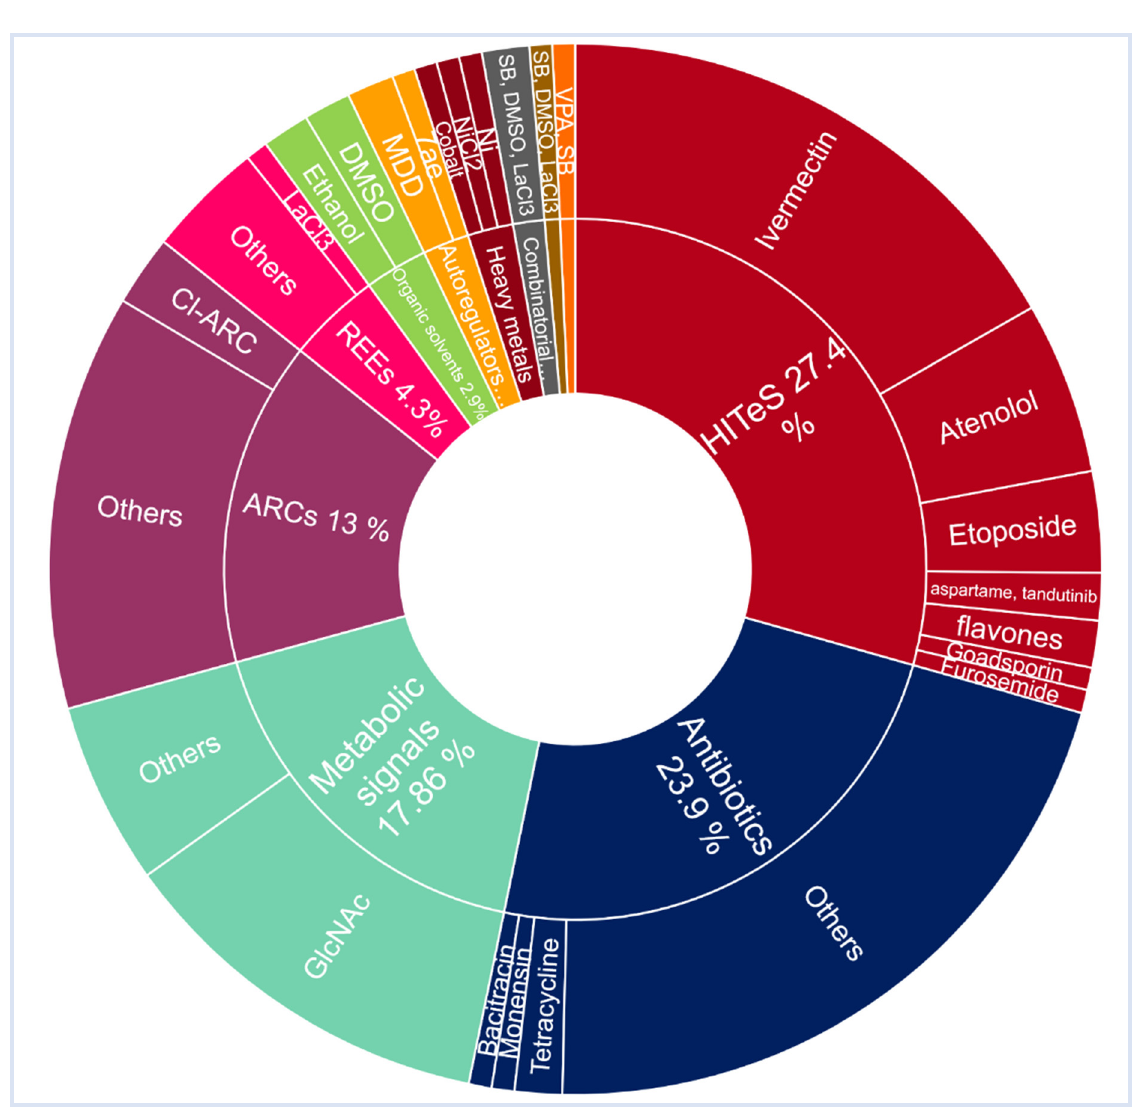
Figure 12. Chemical elicitors used to enhance the production of secondary metabolites.